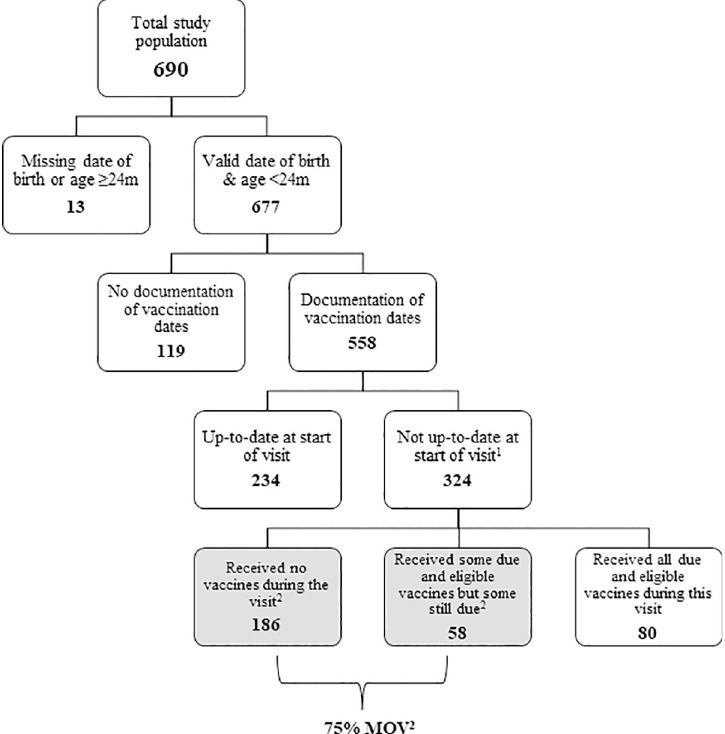
Fig 1. Health-center-based flow-chart for determining missed opportunities for vaccination, Kenya, 2016. 1 All children were without contraindications; 2 Missed opportunity for vaccination (MOV): contact with health services by a child (or adult) who is eligible for vaccination (unvaccinated, partially vaccinated, or not up-to-date, and free of contraindications to vaccination), which does not result in the individual receiving all vaccine doses for which they are eligible [1,